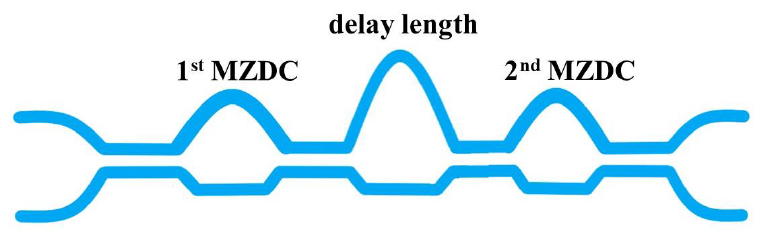
Figure 4. The schematic drawing for Tandem MZDC.